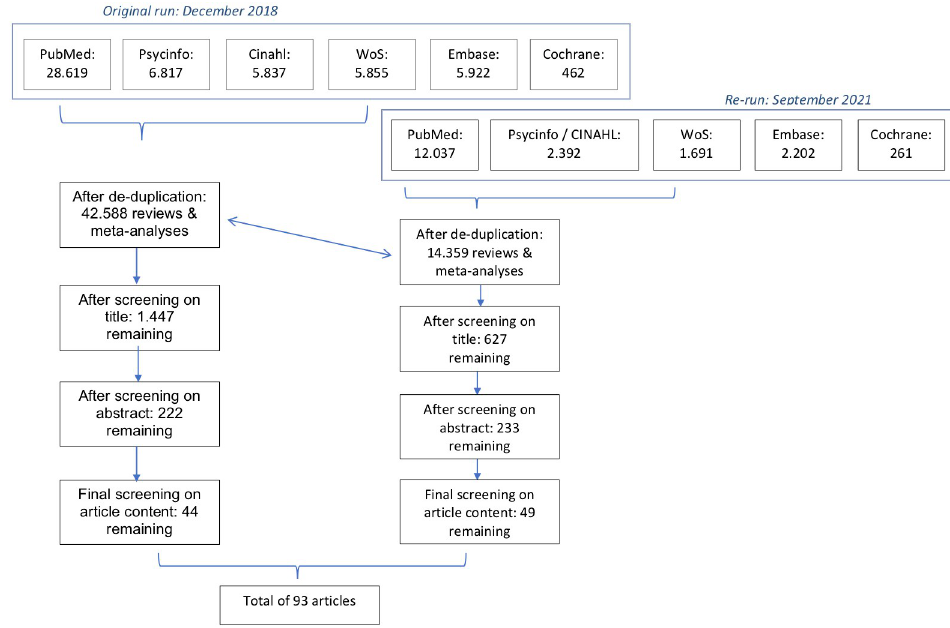
Fig 1. Flow chart of the article screening process.